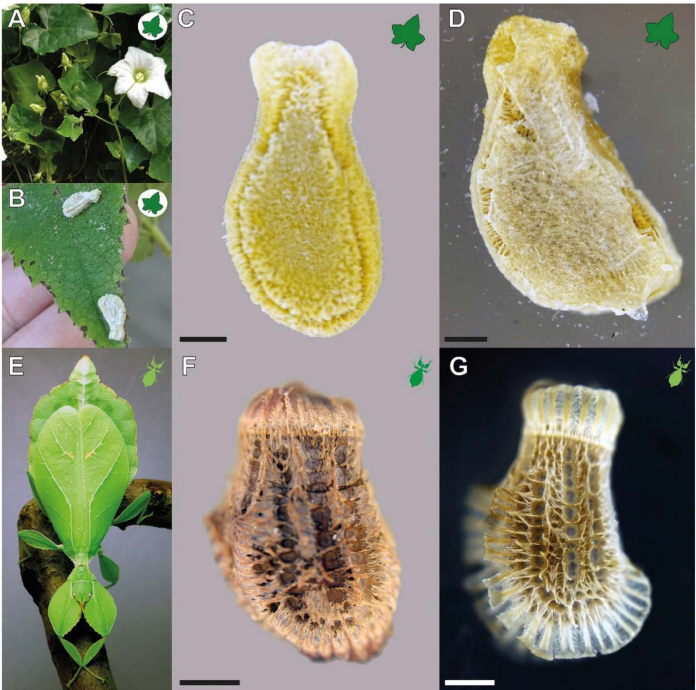
Figure 1. Focal organisms. ( A – D ) Coccinia grandis : ( A ) Flowering plant (modified from [16], published under CCBY 4.0). ( B ) Seeds found in the field attached to the leaves of a different plant (provided by Lih Wei-Song). ( C ) Extracted dry seed before water contact. ( D ) Seed attached to a glass slide, photographed through the slide. ( E – G ) Phyllium philippinicum : ( E ) Adult female (from [15] published under CCBY 4.0). ( F ) Dry egg before first water contact, lateral view. ( G ) Egg attached to a glass slide, photographed through the slide. Scale bars: 1